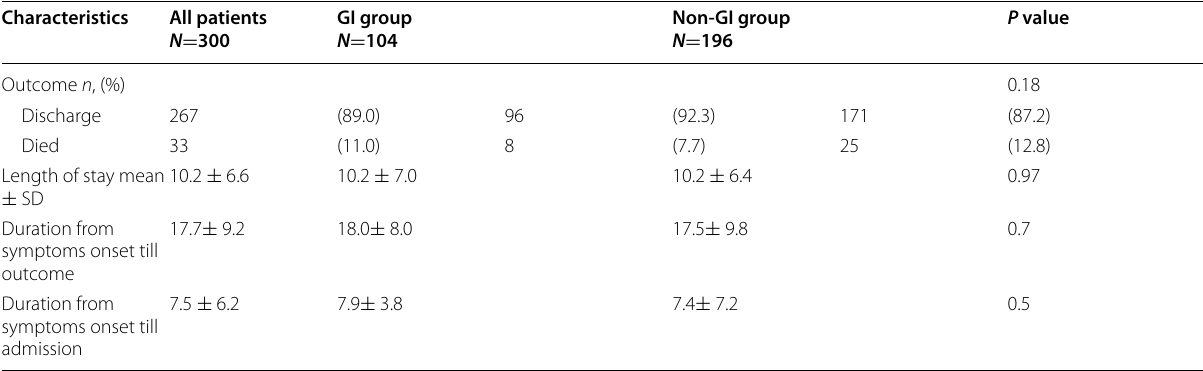
Table 4 Outcome of patients with COVID-19